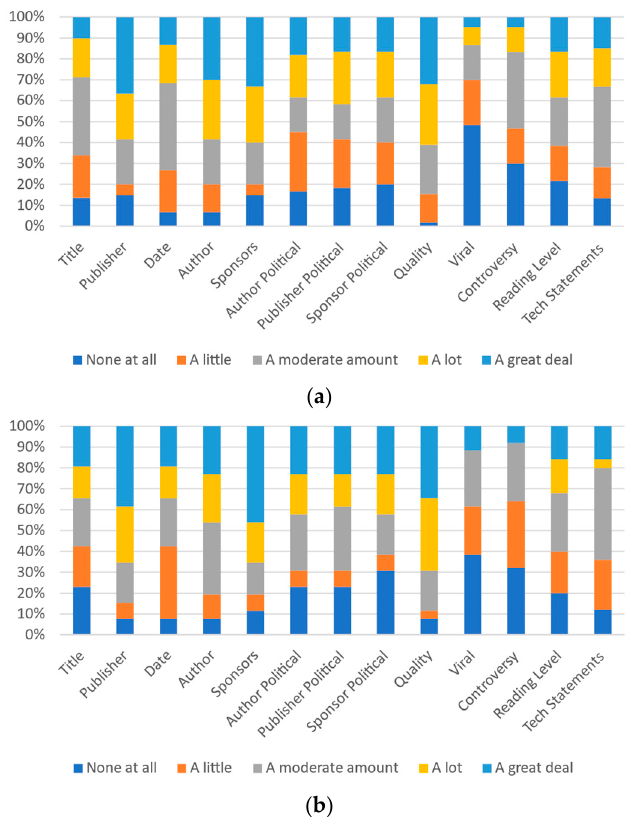
Figure 11. Participants’ responses on the ideal magnitude of each category’s effect on perception of trustworthiness or credibility: ( a ) 18–29 and ( b ) 30+.